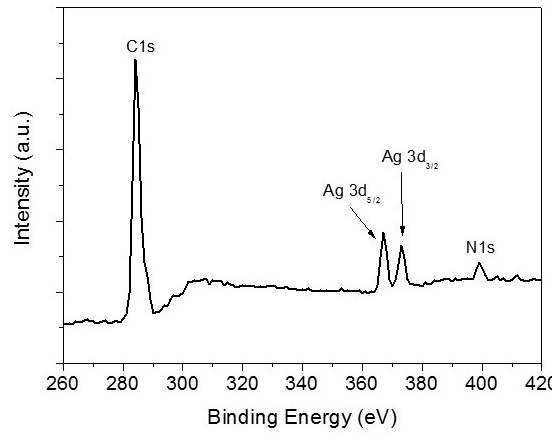
Figure 3. XPS spectrum of the C1s, Ag3d, and N1s peaks of GO–peptide–AgNPs nanohybrids.